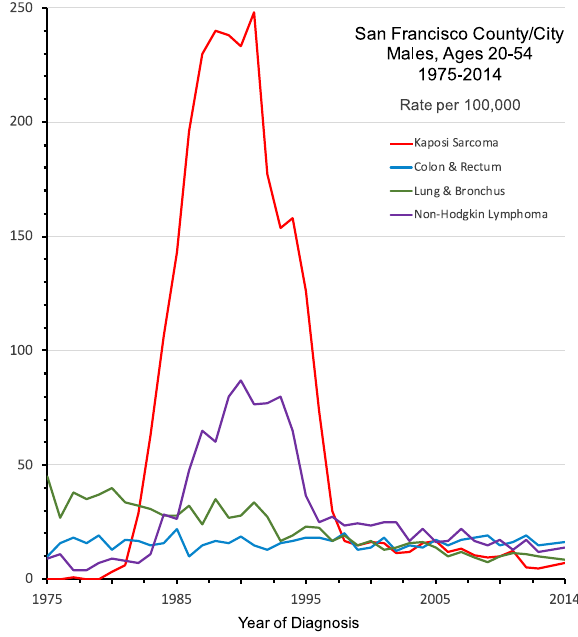
Fig. 1 The Kaposi sarcoma epidemic. U.S. National Cancer Institute ’ s Surveillance, Epidemiology and End-Results (SEER) data for San Franciscan men shows the emergence and magnitude of this epidemic cancer caused by transmissible KSHV infection during the AIDS epidemic (Howlader, N., Noone, A.M., Krapcho, M., Miller, D., Bishop, K., Kosary, C.L., Yu, M., Ruhl, J., Tatalovich, Z., Mariotto, A., Lewis, D.R., Chen, H.S., Feuer, E.J., Cronin, K.A. (eds). SEER Cancer Statistics Review, 1975 – 2014, National Cancer Institute, Bethesda, MD,